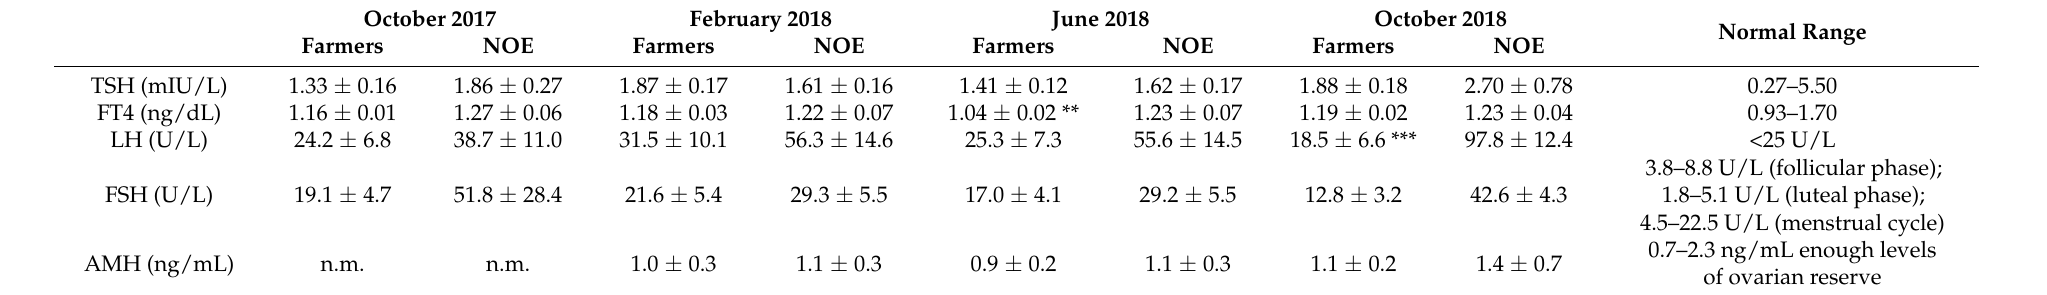
Table 4. Effects on hormonal levels in farmer women and in non-occupational exposed (NOE) groups. Data are expressed as the mean ± SEM. ** p < 0.01; *** p < 0.001 versus NOE group. AMH: anti-Müllerian hormone; FSH: follicle stimulating hormone; FT4: free thyroxine; LH: luteinizing hormone; n.m.: not measured; TSH: thyroid-stimulating